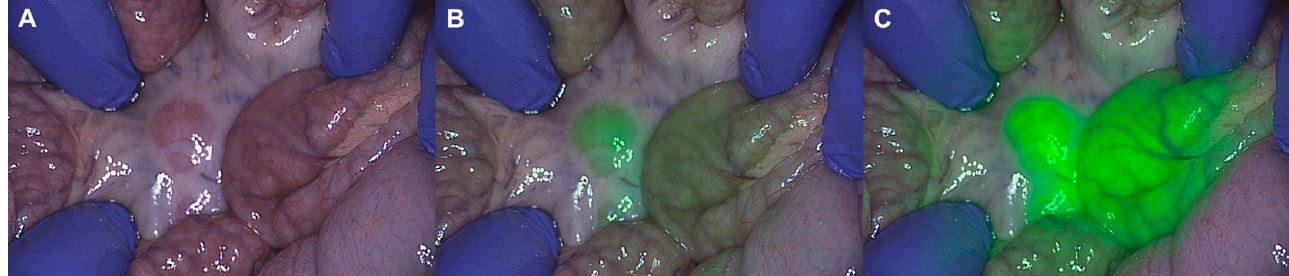
Figure 2. Picture of mesenteric lymph nodes and bowel after 20 min of intravenous MB and ICG administrations. ( A ) The RGB image. ( B ) Overlay fluorescence picture at 700 nm (fluorescence for MB). ( C ) Overlay fluorescence picture at 800 nm (fluorescence for ICG). MB, methylene blue; ICG, indocyanine green.